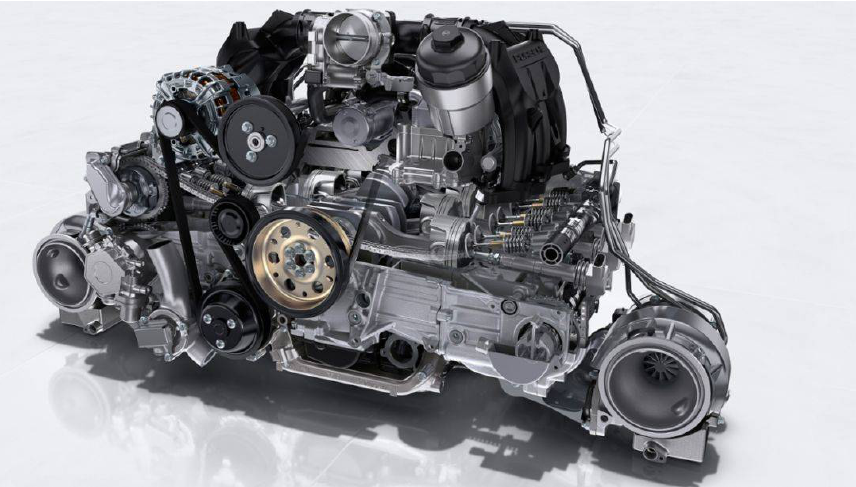
Figure 14. Porsche Six Cylinder Turbo 3.0 L [70].